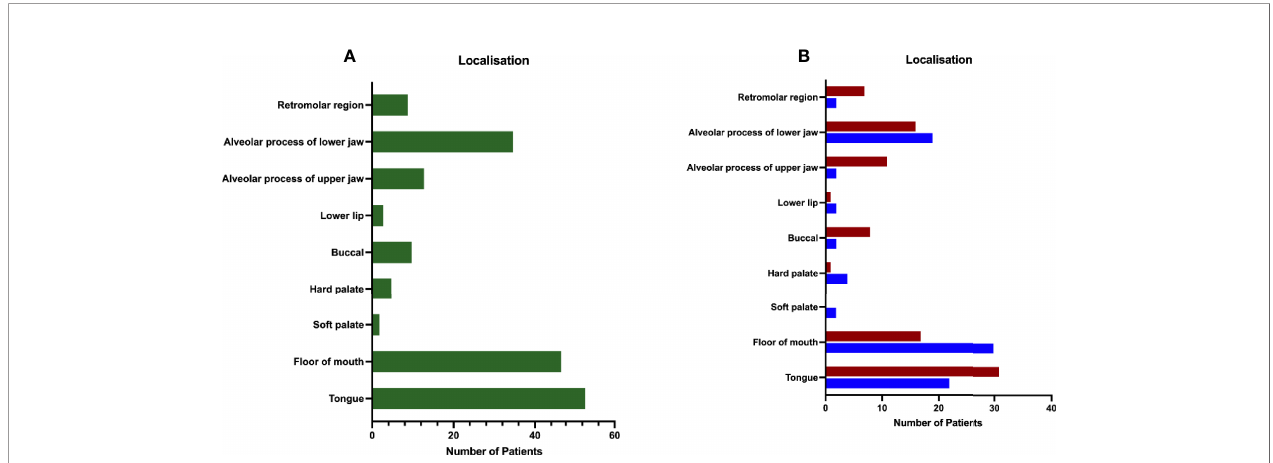
FIGURE 2 | Distribution of patients by primary site. (A) The majority of the patient collective was diagnosed with primary tumor in tongue (33.70%), fl oor of mouth (FOM; 26.55%), and the alveolar process of the lower jaw (19.77%), followed by tumors located in the buccal (5.65%) and retromolar (5.08%) regions, hard palate (2.82%), alveolar process of the upper jaw (7.34%), the lower lip (1.69%), and the soft palate (1.13%). (B) Distribution of primary tumor site according to gender shows two times more tumors for FOM in male patients (m: 35.29%/f: 18.48%), whereas in female patients more were diagnosed with tumors located in the buccal (m: 2.35%/f: 8.70%) or retromolar region (m: 2.35%/f: 7.61%). Data are presented as total values, based on n=177